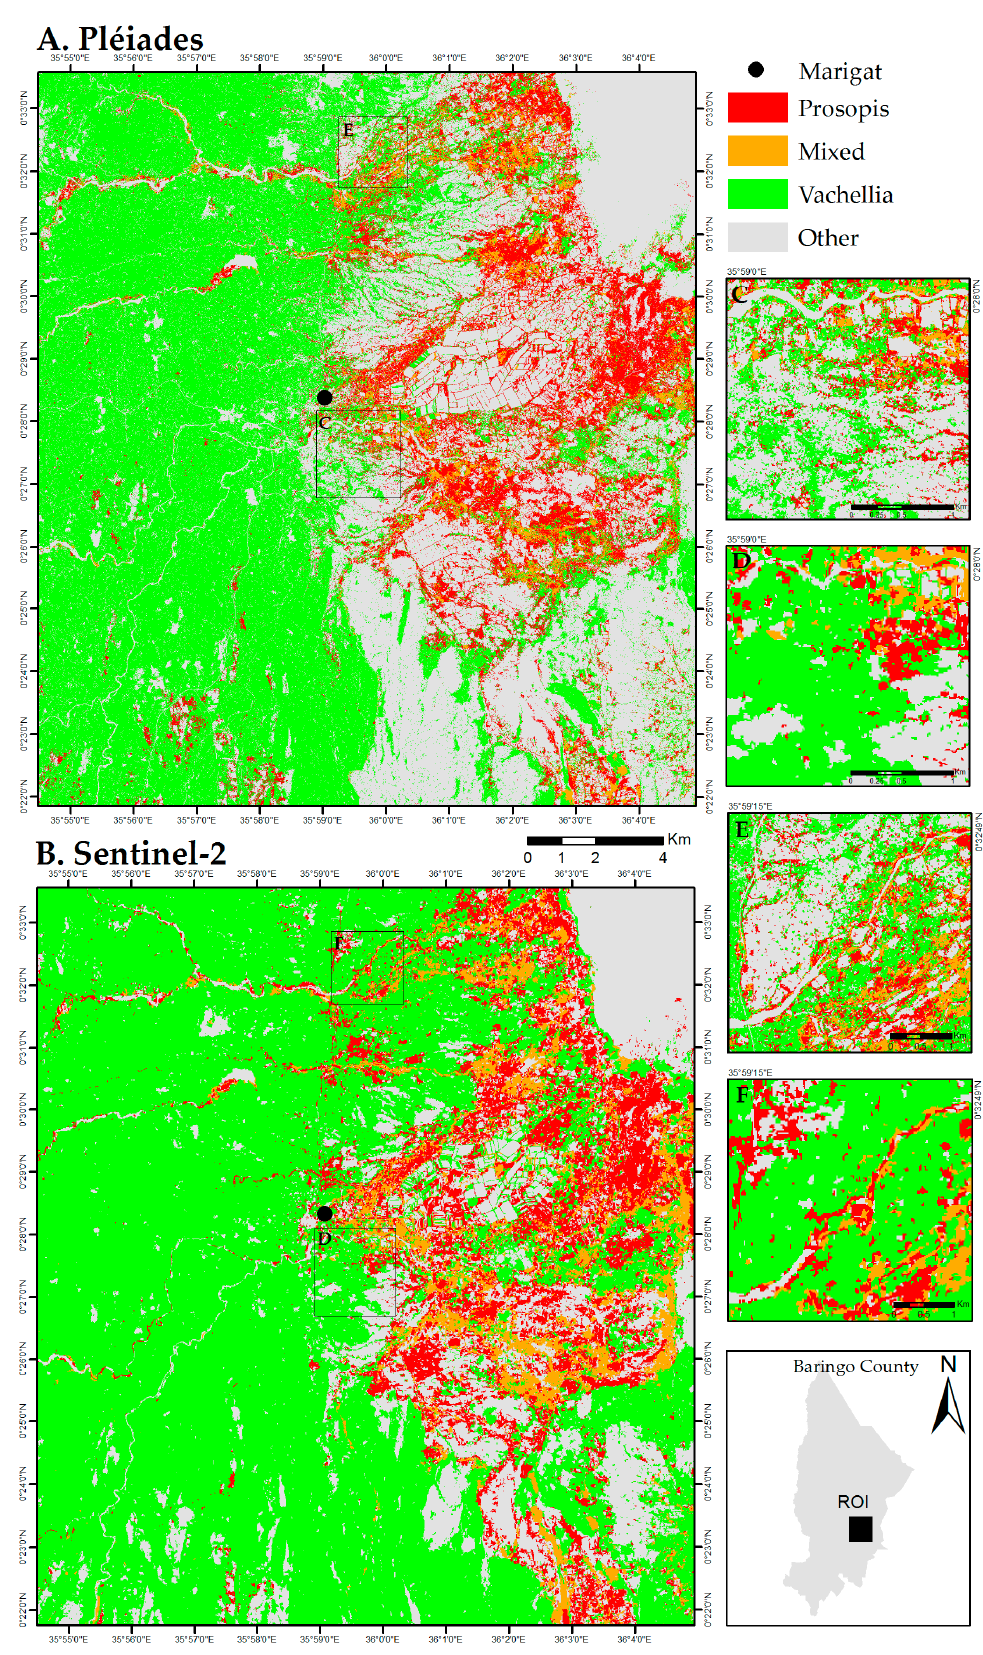
Figure 7. Classification results including Prosopis , Vachellia , Mixed and Other illustrating: ( A ) the Pléiades results; ( B ) the Sentinel-2 results; and comparisons between both sensors in respect of differences in classification ( C , D ); and detection of small vegetated patches ( E , F ). For definition of the re-classified (broad) classes, refer to Table 3.